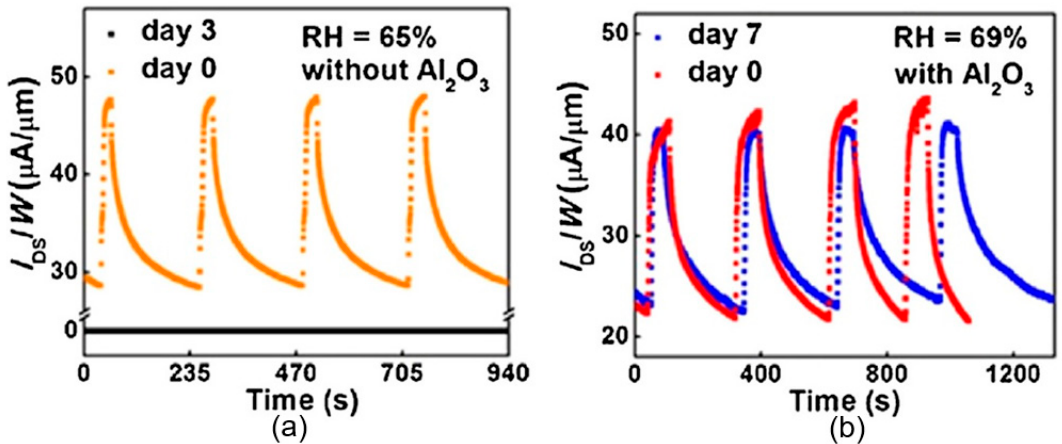
Figure 15. Long-term stability of the BP humidity sensors: ( a ) dynamic sensing response for the unencapsulated BP sensor right after fabrication (orange) and after being stored in ambient for 3 days (black); (black line RH ~21%, orange line RH ~65%); ( b ) dynamic sensing response for the encapsulated BP sensor right after fabrication (red) and after being stored in ambient for 7 days (blue) (blue line RH ~21%, red line RH ~69%). Reproduced with permission from Ref. [125]. Copyright American Chemical Society, 2017.